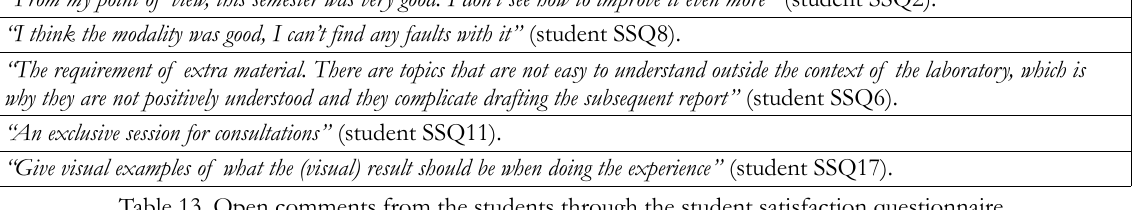
Table 13. Open comments from the students through the student satisfaction questionnaire